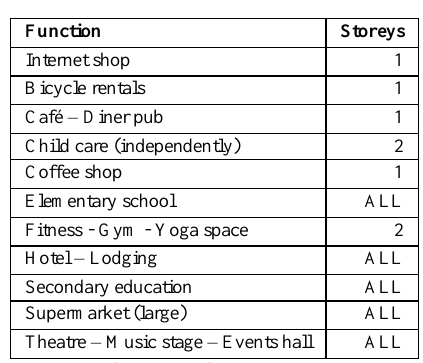
Table 1. Number of (maximum) storeys for each non-residential category in a building. “ALL” means the total height of the building containing such activity.